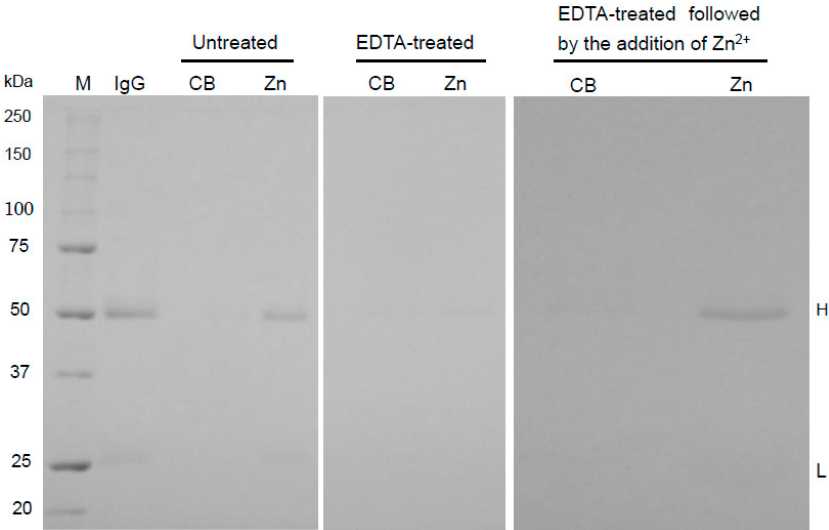
Figure 2. Effect of ethylenediaminetetraacetic acid (EDTA) on the binding of human IgG to Zn-beads. Zn-beads and CB were treated with or without 50 mM EDTA (pH 7.4). After washing, PBS (980 µ L) containing human IgG (25 µ g) was added to aliquots of the treated and untreated Zn-beads and CB (net volume of beads per sample: 20 µ L). Different aliquots of EDTA-treated CB and Zn-beads were washed and incubated with 1 mL 50 mM ZnSO 4 , rotated overnight, and then the ZnSO 4 -treated beads were washed and suspended at 50% ( v / v ) in PBS. Aliquots (1 mL) of IgG (25 µ g) and ZnSO 4 -treated beads (Zn-beads or CB) in PBS were prepared (net volume of beads per sample: 20 µ L each), and incubated at 4 ˝ C overnight. As described in the “Experimental Section”, the obtained bead sample was analyzed by SDS-PAGE; human IgG (IgG) was also applied to the gel (2 µ g/lane), and the separated H and L subunits were denoted H and L, respectively. M represents marker